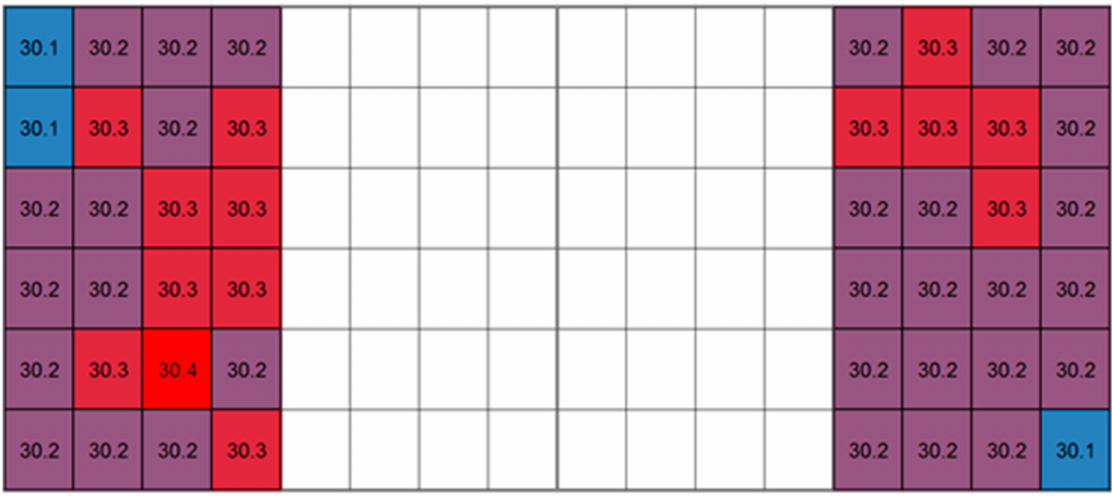
Figure 4. Heat-map of ‘TeeBot’ flask temperatures in Generation#1 instrument. An average temperature of 30.2 ± 0.1 ◦ C was observed across wells held in a set temperature of 30 ◦ C ( n =